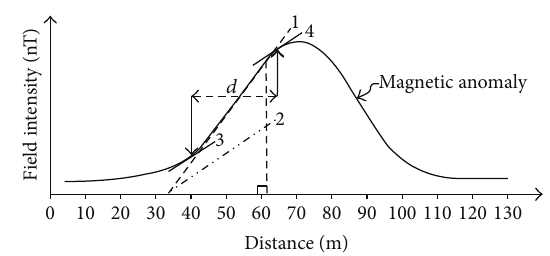
Figure 3: Peter’s half-slope method of depth-to-basement determi-